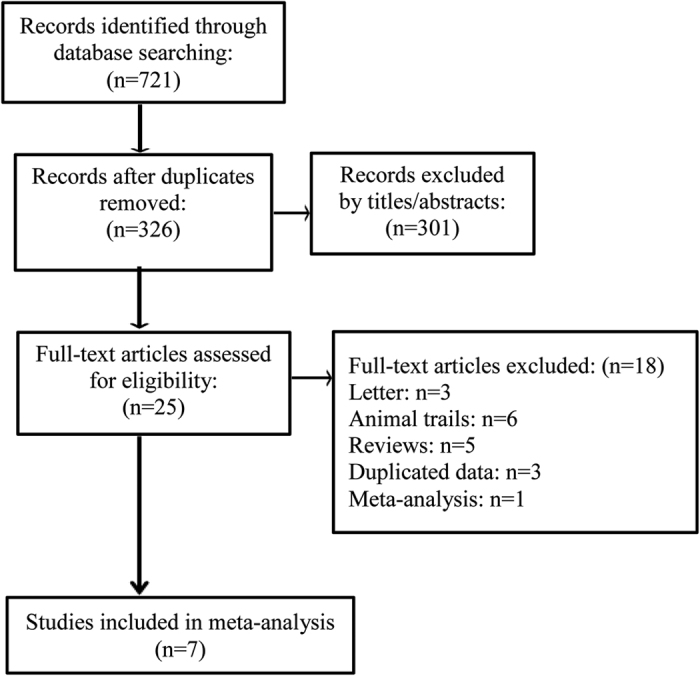
Flow chart of publication selection procedure.